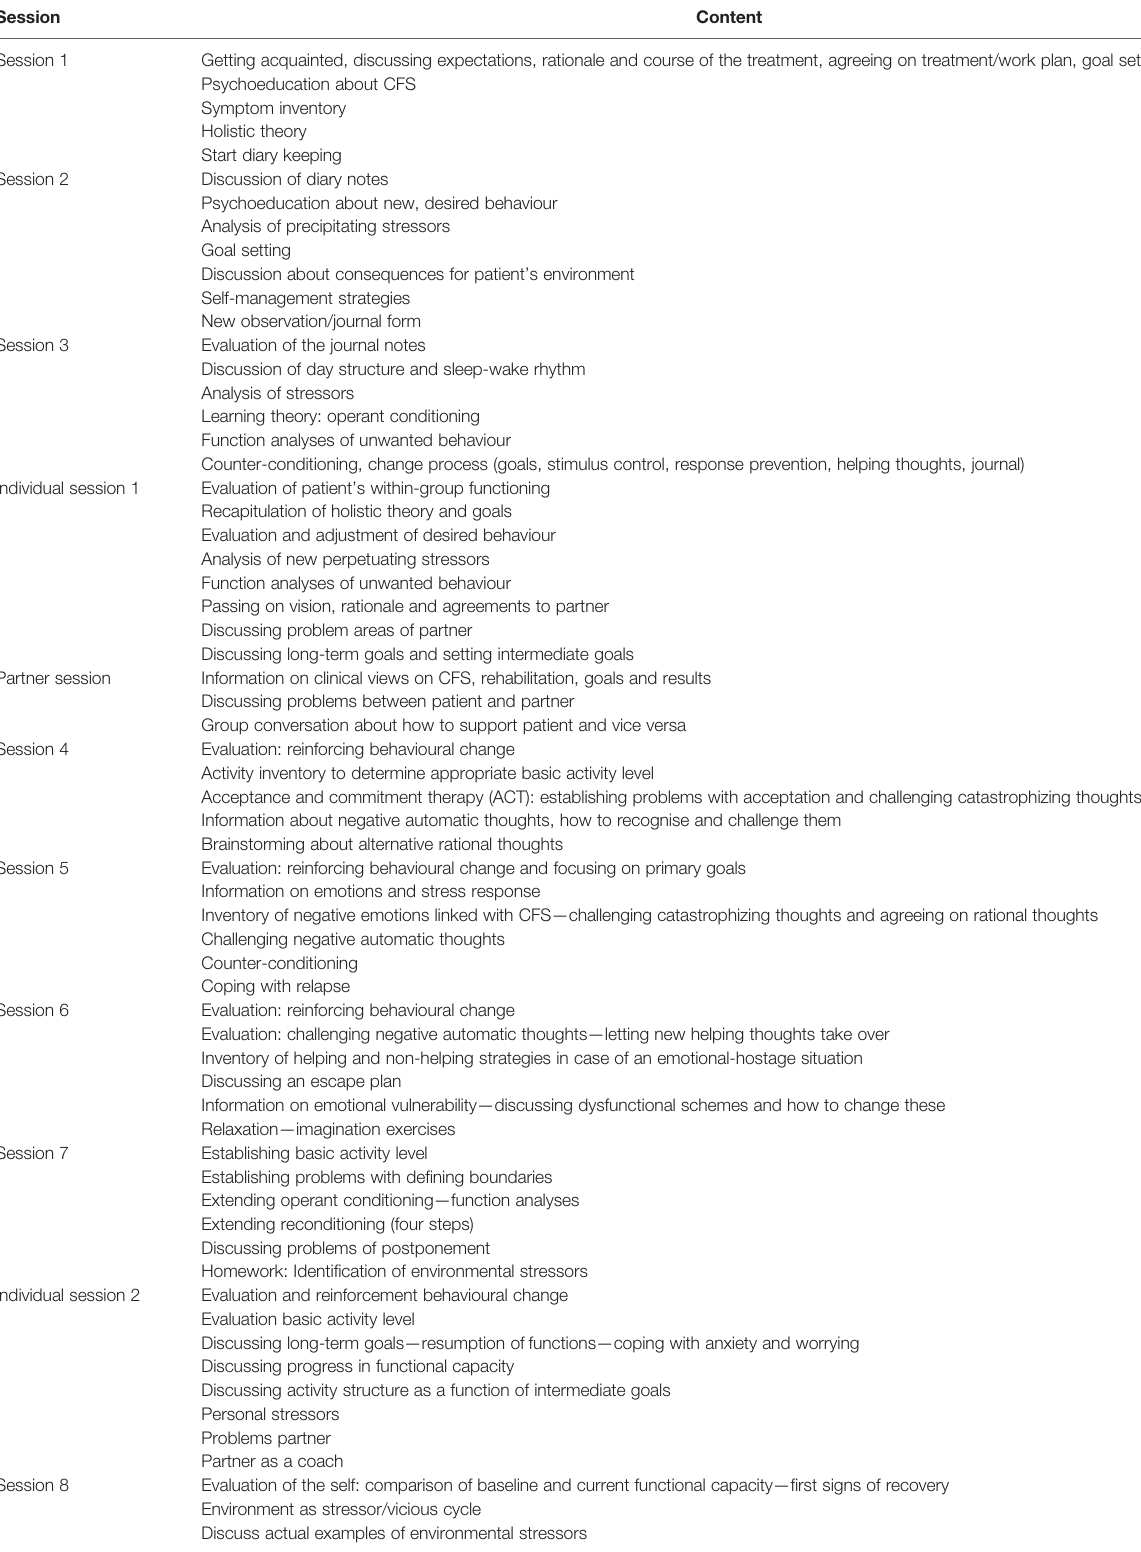
TABLE 1 | Overview of the standardised GCBT for CFS sessions as delivered in the study. Session